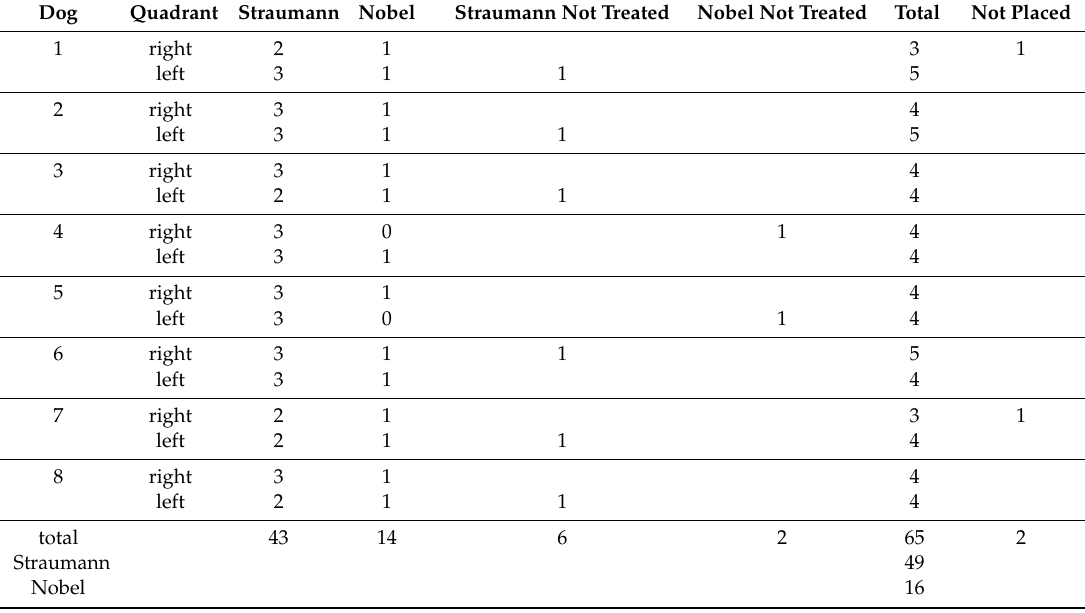
Table 1. Allocation of implant